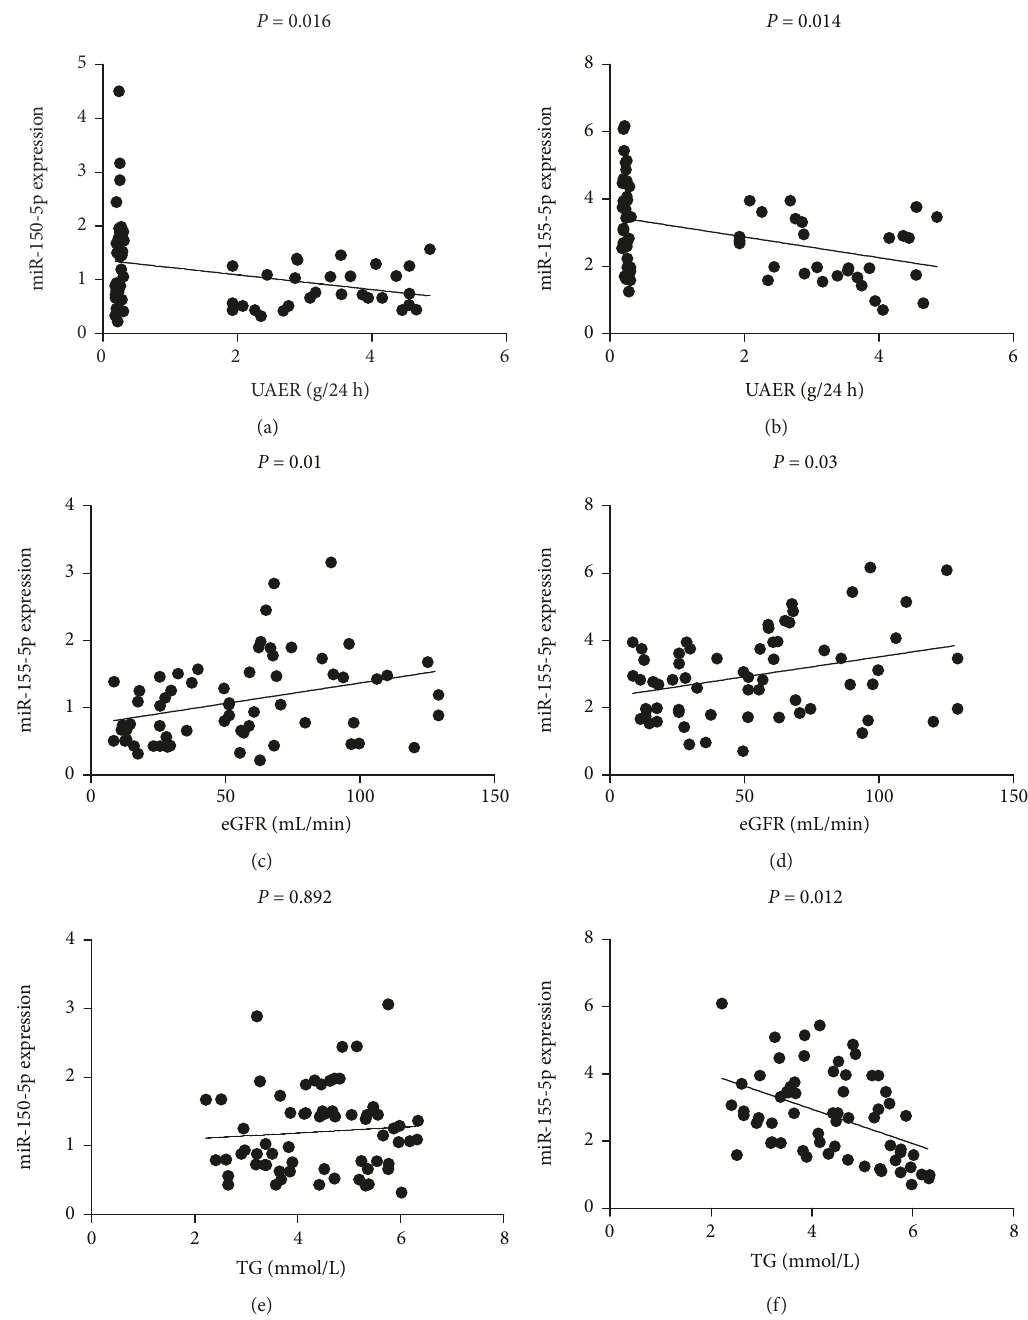
Figure 5: The correlation of plasma miR-150-5p and miR-155-5p expression levels with clinical parameters in patients with DN. Plasma miR-150-5p ( P = 0 016 , r = − 0 460 ; (a)) and miR-155-5p ( P = 0 014 , r = − 0 467 ; (b)) were negatively correlated with UAER. Plasma miR- 150-5p ( P = 0 01 , r = 0 318 ; (c)) and miR-155-5p ( P = 0 030 , r = 0 271 ; (d)) were positively correlated with eGFR values. (e) No correlation was observed between miR-150-5p and triglycerides ( P = 0 892 , r = 0 027 ). (f) Plasma miR-155-5p expression was positively correlated with triglycerides ( P = 0 012 , r = − 0 403 ). UAER: urinary albumin excretion rate; EGFR: estimated glomerular fi ltration rate; TG: